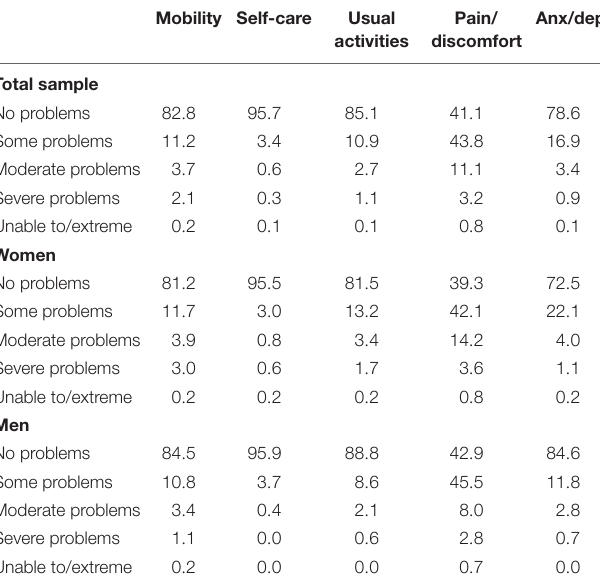
TABLE 3 | Quality of life among older adults.